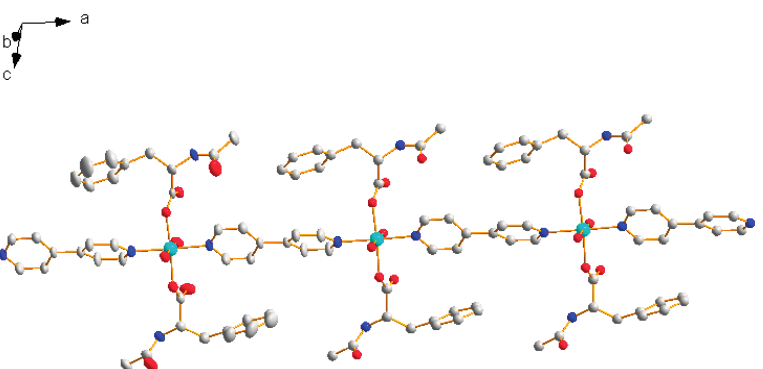
Figure 2. Crystal packing of 1 .